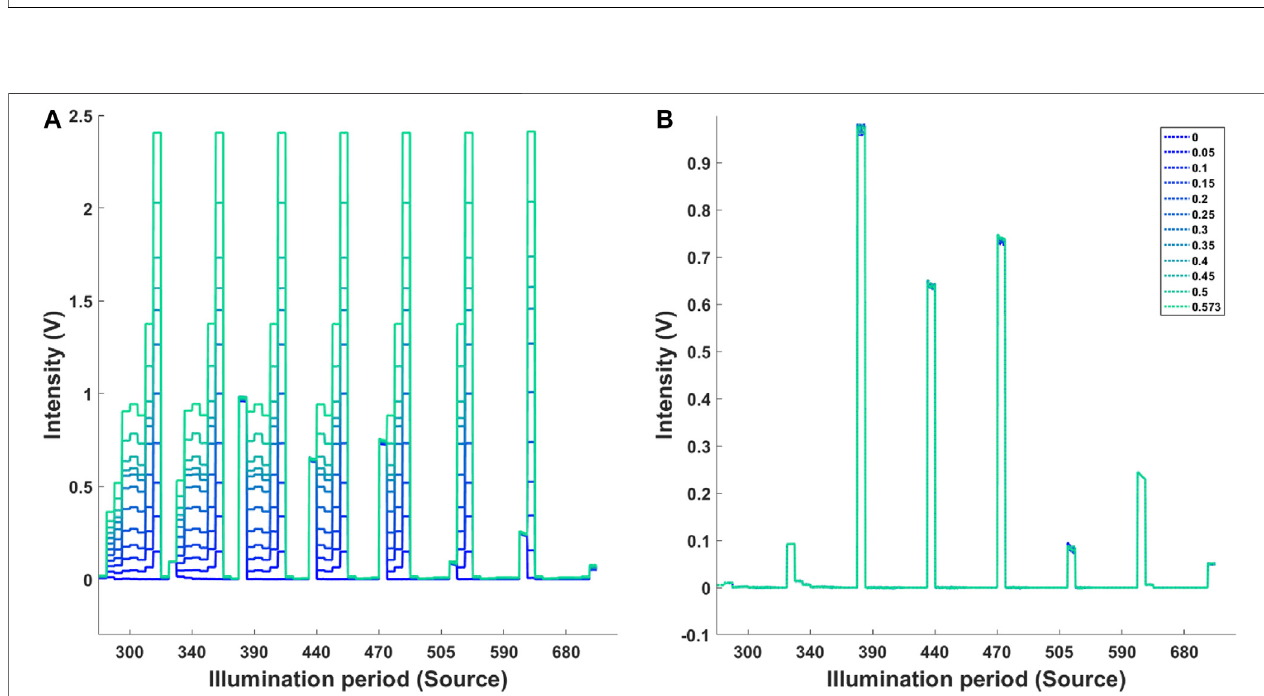
FIGURE 4 | (A) Measured background intensity at high and low gain. The diffuse re fl ectance was measured at low gain setting. The increasing background illumination at high gain is highlighted by the colour coded plots. (B) Signal after background subtraction. Legend indicated the power of background illumination (W).